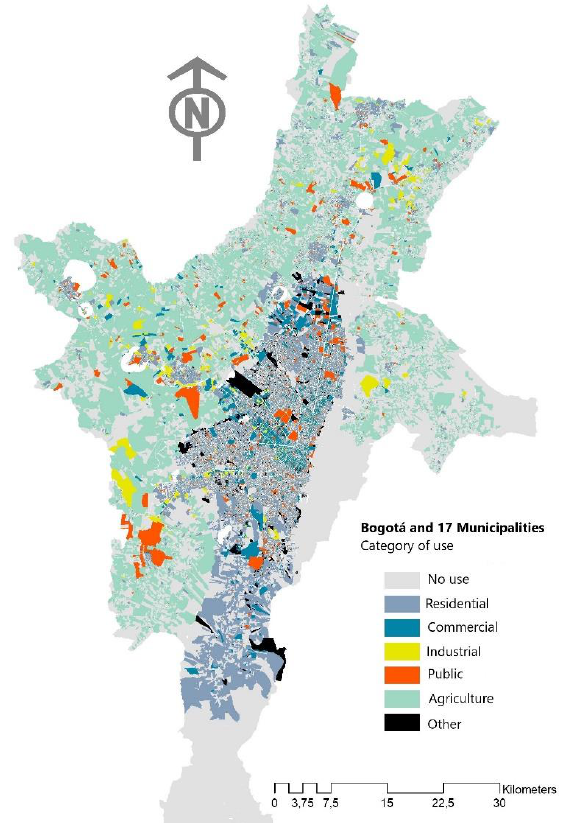
Figure 2. Predominant land use in Bogotá and 17 municipalities. Based on information from the IGAC and the Bogota District